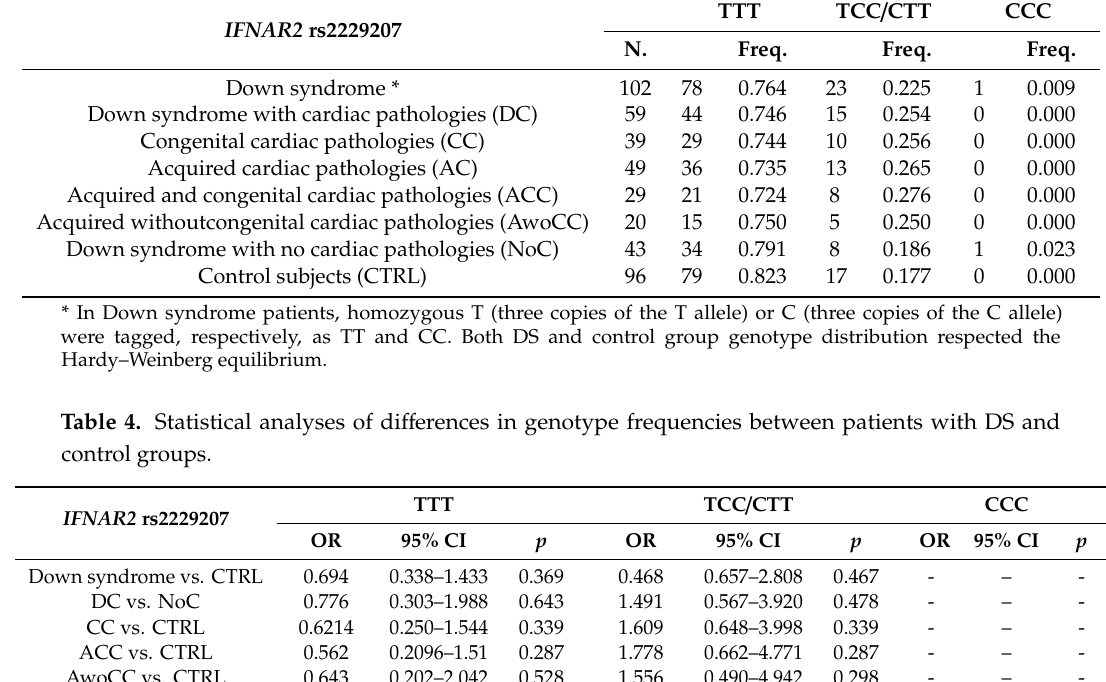
Table 3. IFNAR2 rs2229207 genotype frequencies of Down syndrome (DS) patient and control groups. IFNAR2 rs2229207